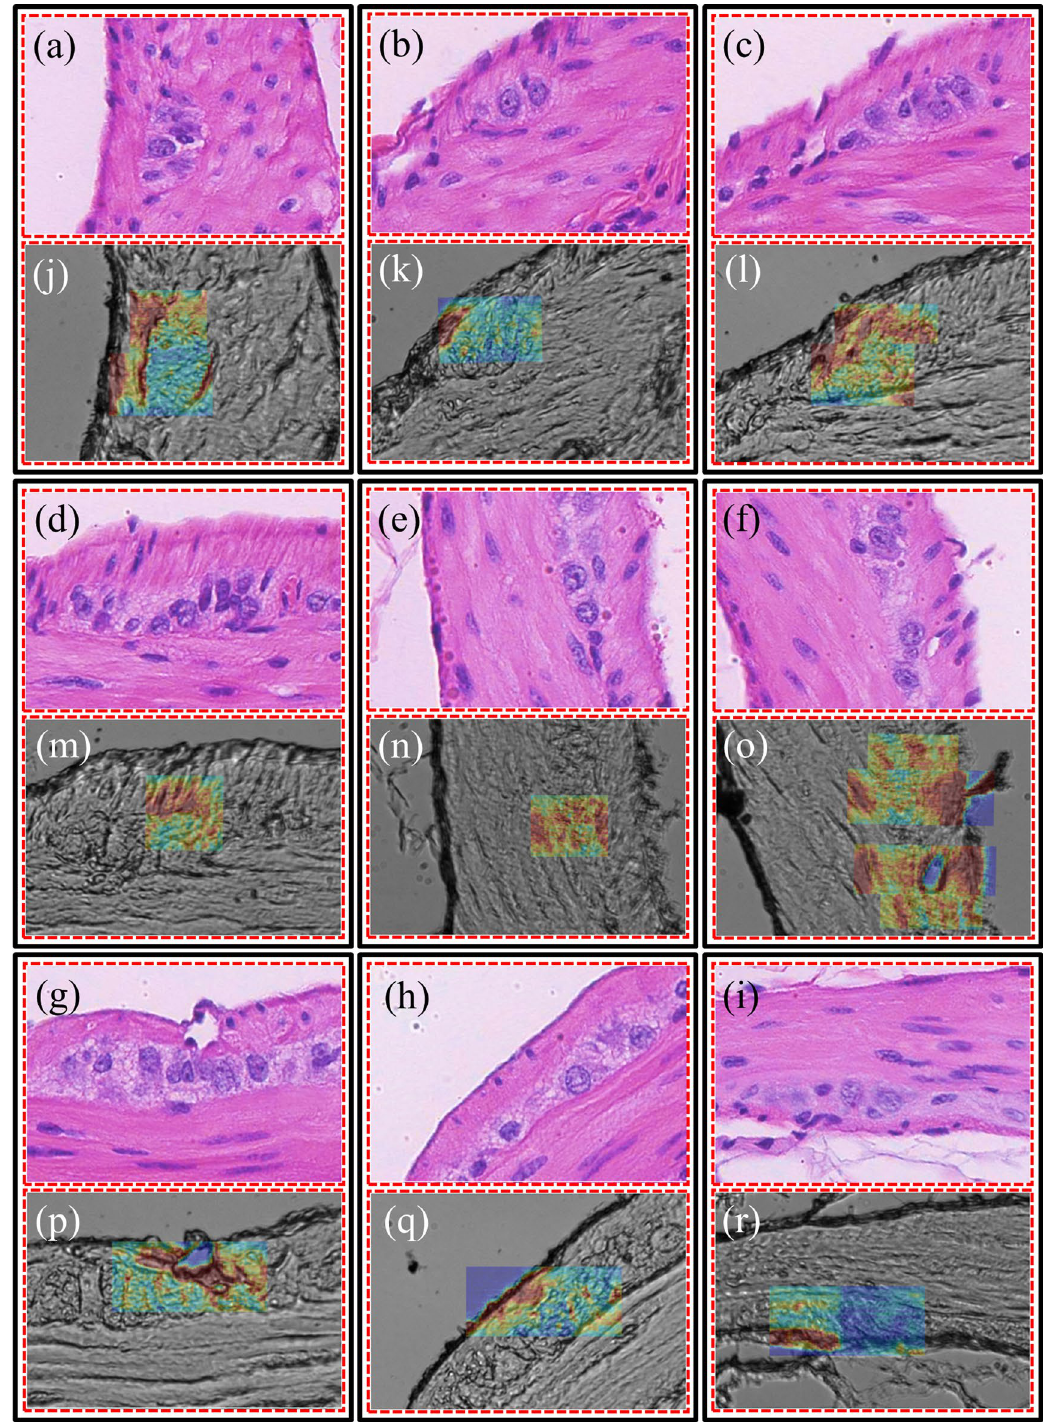
Figure 5. Brightfield images ( a – i ) from H&E stained areas, indicated by dashed red rectangles in Fig. 3, and ( j – r ) from the near-identical unstained areas with overlaid Raman imaging (by using the 1450 cm −1 peak) in areas containing ganglion